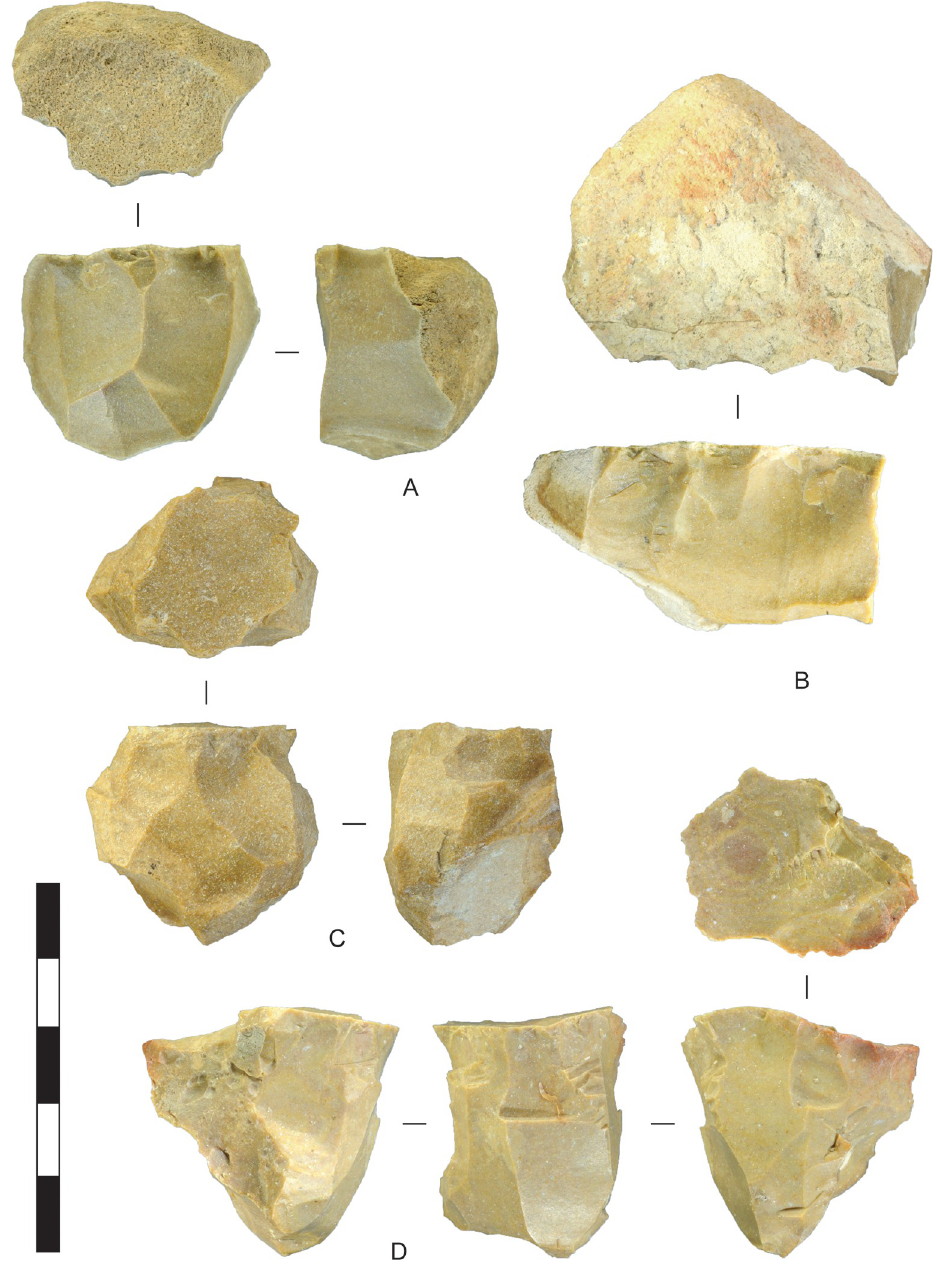
Fig 13. Chert single platform cores, Horizon IV, Saruq al-Hadid. (A, B) Cores reduced around part of the perimeter from cortical platform surfaces. (C, D) Cores reduced around most of the perimeter from a platform composed of a large flake scar. From contexts 1794 (A), 1797 (B), 2018 (C), and 2016 (D). Scale bar 50 mm. (e.g., Fig 13A and 13B). The cobble axis selected for flake production was not always the lon- gest one (e.g., Fig 13B). Sometimes the core was turned after assaying and those negative scars were used as a platform for striking flakes down an adjacent face. Fig 5C shows an assayed cob- ble with the initial flake-scar platform established, but the core was abandoned at that point. Fig 13C and 13D are cores where the flake-scar platform was used to strike flakes from around